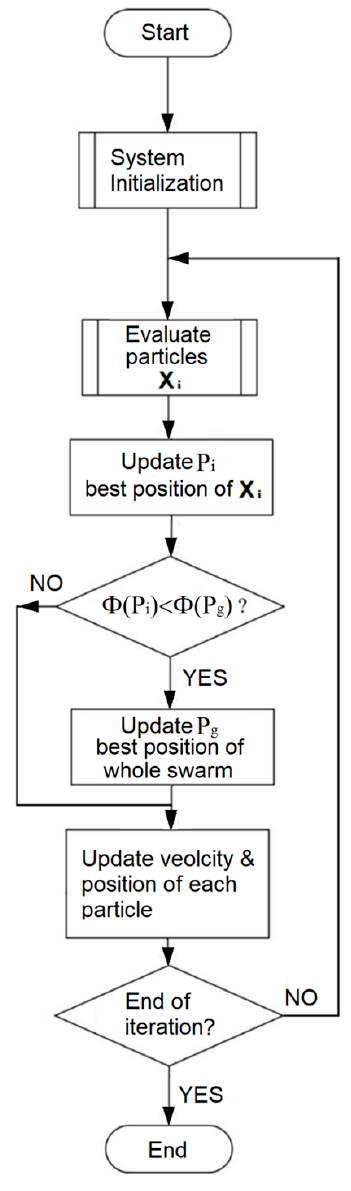
Figure 1. PSO Algorithms.